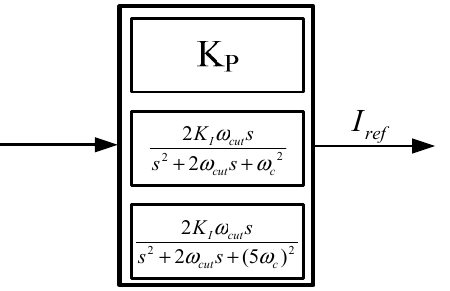
Figure 10. PR controller to neutralize the fifth order harmonic component.